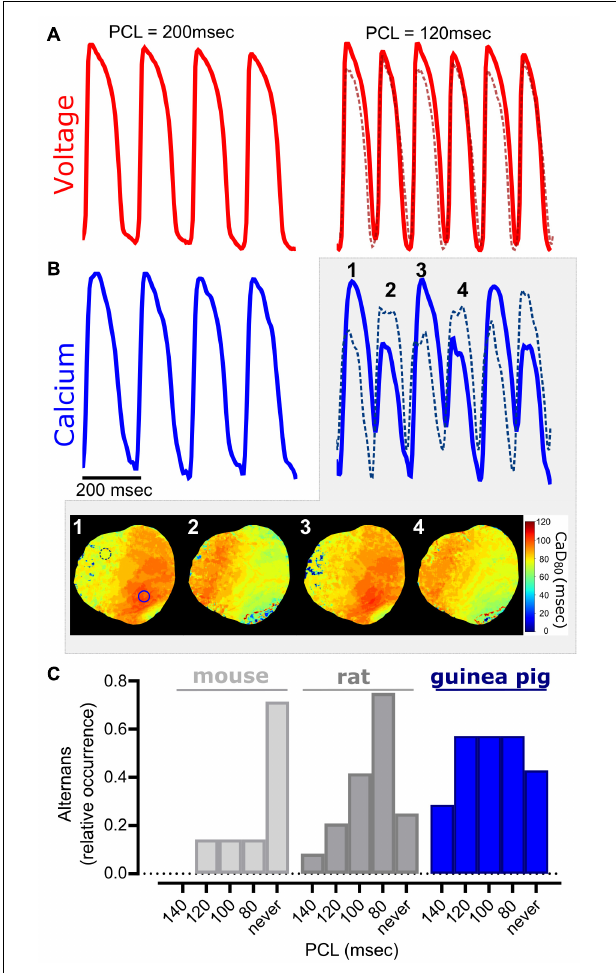
FIGURE 7 | Cardiac alternans occur at faster pacing cycle lengths. (A) Representative optical action potentials, and (B) calcium transients from a Langendorff-perfused guinea pig heart. Slower PCL (200 ms) produces uniform action potentials and calcium transients (left), while a faster PCL (140 ms) results in cardiac alternans (right). Traces were acquired from two different regions of interest (solid line—left ventricle, dotted line—right ventricle) and discordant alternans were readily observable in the calcium signal. Four sequential beats show regional differences in alternans in calcium duration maps. (C) Relative occurrence of cardiac alternans in different species (mouse, rat, guinea pig). Epicardial dynamic pacing applied to the left ventricle for all studies ( n = 5–18 independent heart studies per